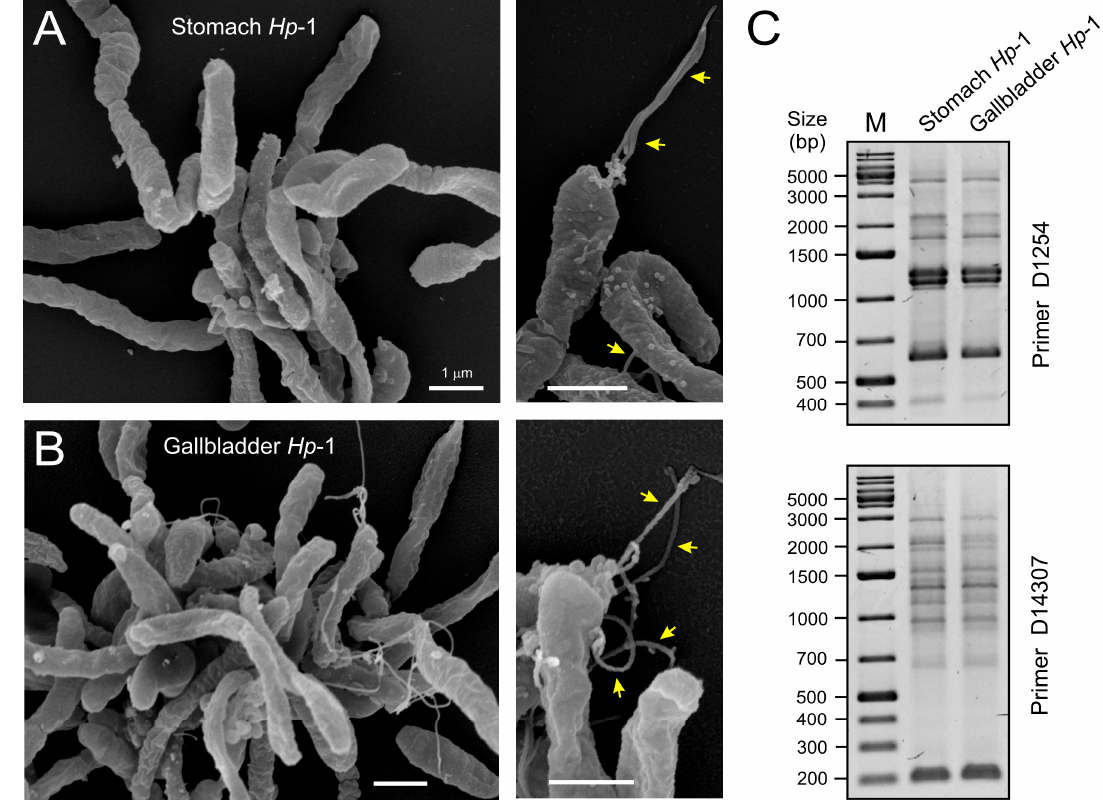
Figure 4. Scanning electron microscopic and genetic analyses of the stomach and gallbladder H. pylori isolates. High resolution scanning electron microscopy of the cultures obtained from the stomach ( A ) and gallbladder ( B ) of the same patient revealed spiral-shaped H. pylori bacteria. Arrows in the enlarged sections indicate typical monopolar flagella being present; ( C ) PCR-based randomly amplified polymorphic DNA (RAPD) produced identical fingerprints for the two H. pylori strains isolated from stomach and gallbladder. This method uses a set of single indicated primers (D1254 or D14307, top and bottom), which arbitrarily anneal and amplify genomic DNA resulting in strain-specific fingerprinting patterns. M = DNA size marker.